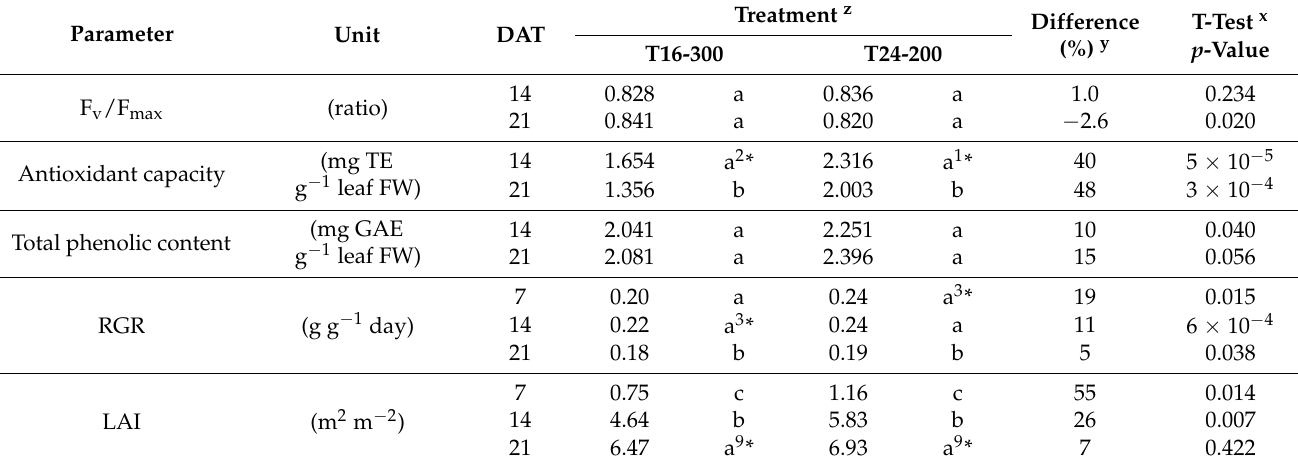
z For the treatment, T16-300 represents the light period of 16 h per day, with a light intensity at 300 µ mol m − 2 s − 1 . T24-200 represents the light period of 24 h per day, with a light intensity at 200 µ mol m − 2 s − 1 . For each treatment and for each growth parameter, the numbers followed vertically (column-wise comparison) by different alphabet letters are statistically different, and the order of magnitude corresponds to the order of the alphabet, i.e., a > b > c. The signs, 1 *, 2 *, 3 *, or 9 *, put after the alphabet ‘a’ at the largest mean for each parameter and each treatment, indicate that the probability of the t -test (for the top three parameters) or of the ANOVA (the multiple comparison by Tukey for the RGR and LAI) is p < 0.05, p < 0.01, p < 0.001, or p < 1.0 × 10 − 10 , respectively. y The rate of the difference between T24-20 and T16-300, i.e., ((T24–T16)/T16) *100. x Double-sided t -test with unequal variances for the mean difference between the two light period treatments (row-wise comparison). The p -values that are less than p = 0.05 are shown in bold